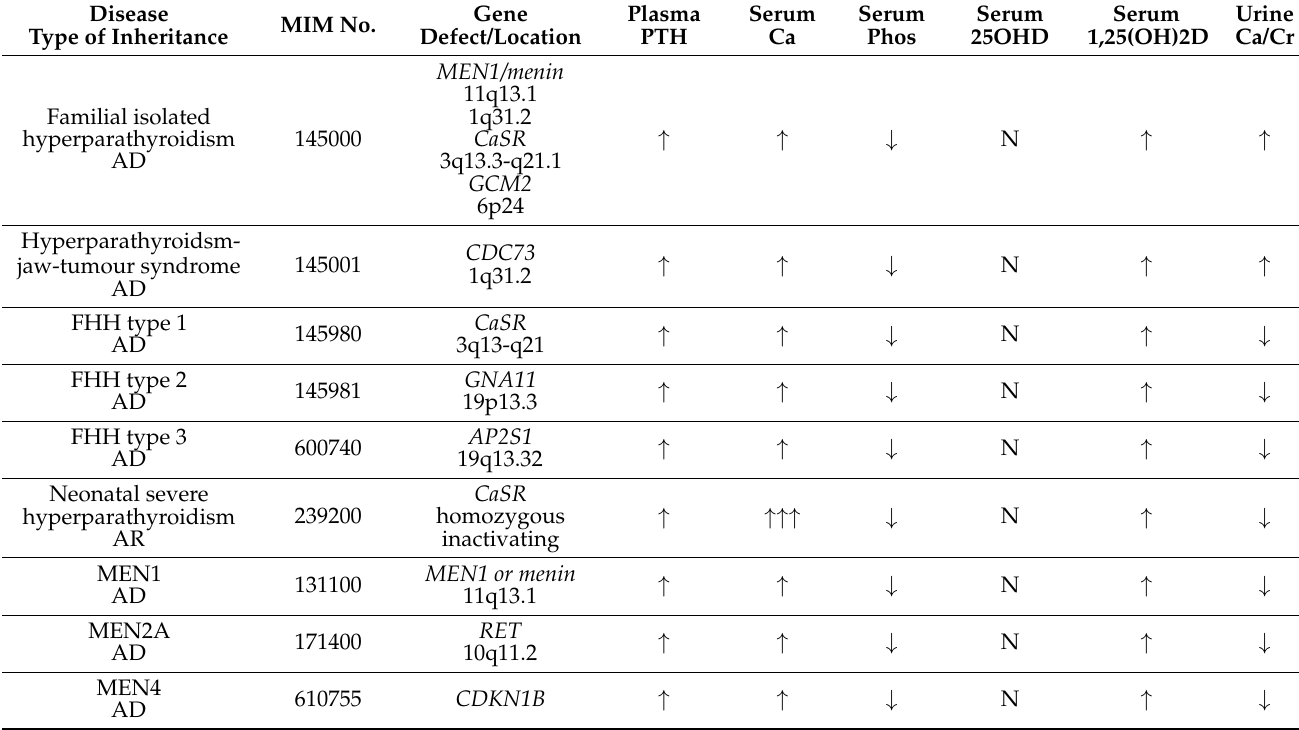
Table 2. Genetic mutations causing